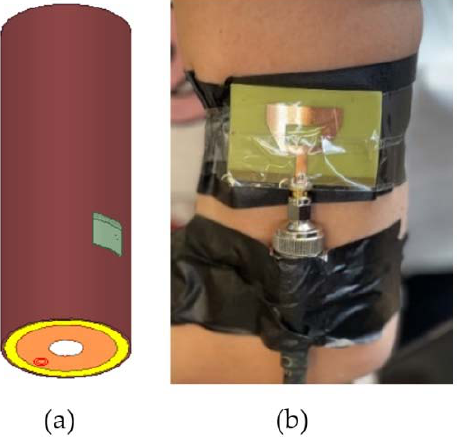
Figure 6. The microstrip patch antenna on the simulated human arm model of ( a ) 45 mm radius versus ( b ) the fabricated microstrip patch antenna on real human arm subject of the same radius.